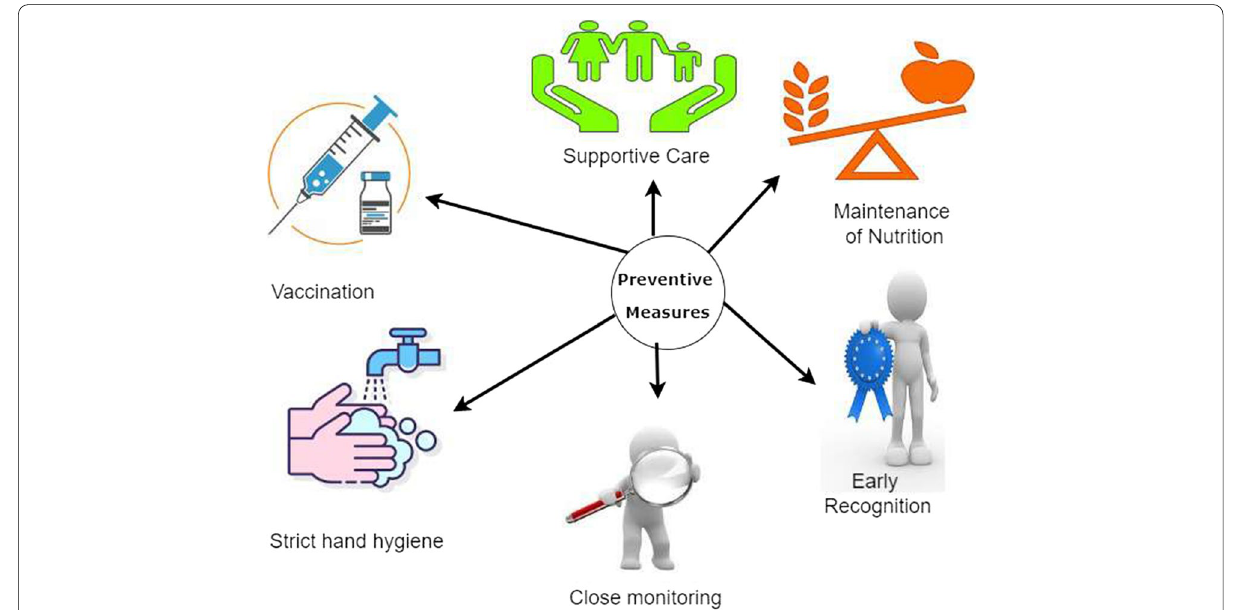
Fig. 5 Preventive measures, the image was drawn by the